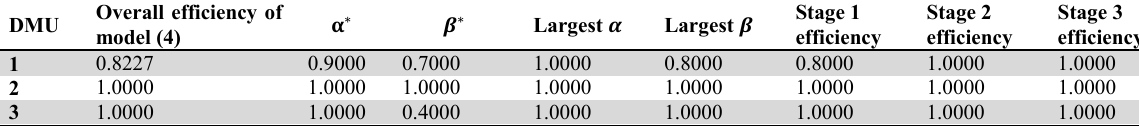
Numerical results for the data in Table 1 with values of (cid:2012)(cid:2009) (cid:3404) (cid:2012)(cid:2010) (cid:3404) 0.1 Overall efficiency of DMU model (4)